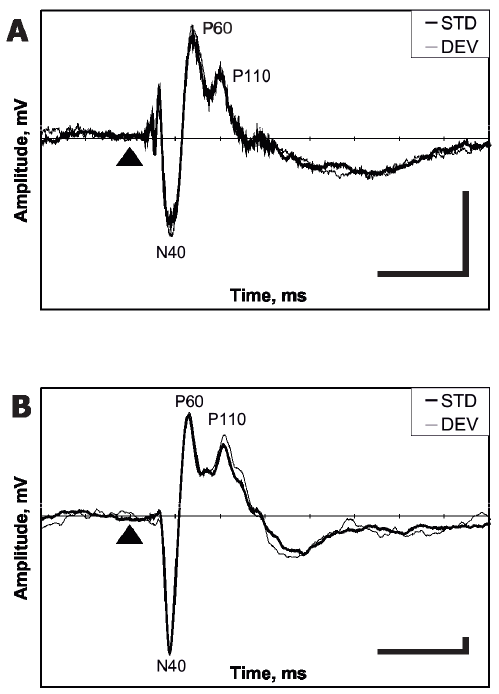
Figure 2. Representative examples of averaged AEPs obtained in the auditory oddball paradigm (grand average of the Day 1 in Experiment 1). Cortical ( A ) and hippocampal ( B ) AEPs. The thin line denotes the response to the deviant tone and the thick line the response to the standard tone. The triangle marks the tone onset. The horizontal bar corresponds to 100 ms, the vertical bar to 0.04 mV (scale for the cortex is five times smaller than that for the hippocampus). Negativity is downward.